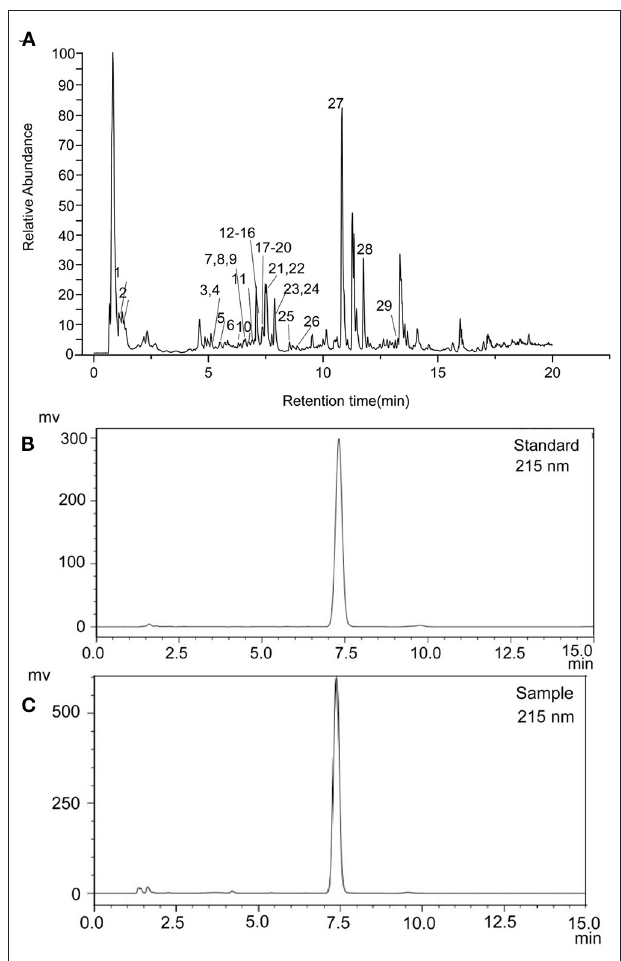
FIGURE 1 | Total ion current chromatograms of pomelo seed extract detected in positive ion mode (A) . HPLC chromatogram of limonin standard (B) and sample (C)